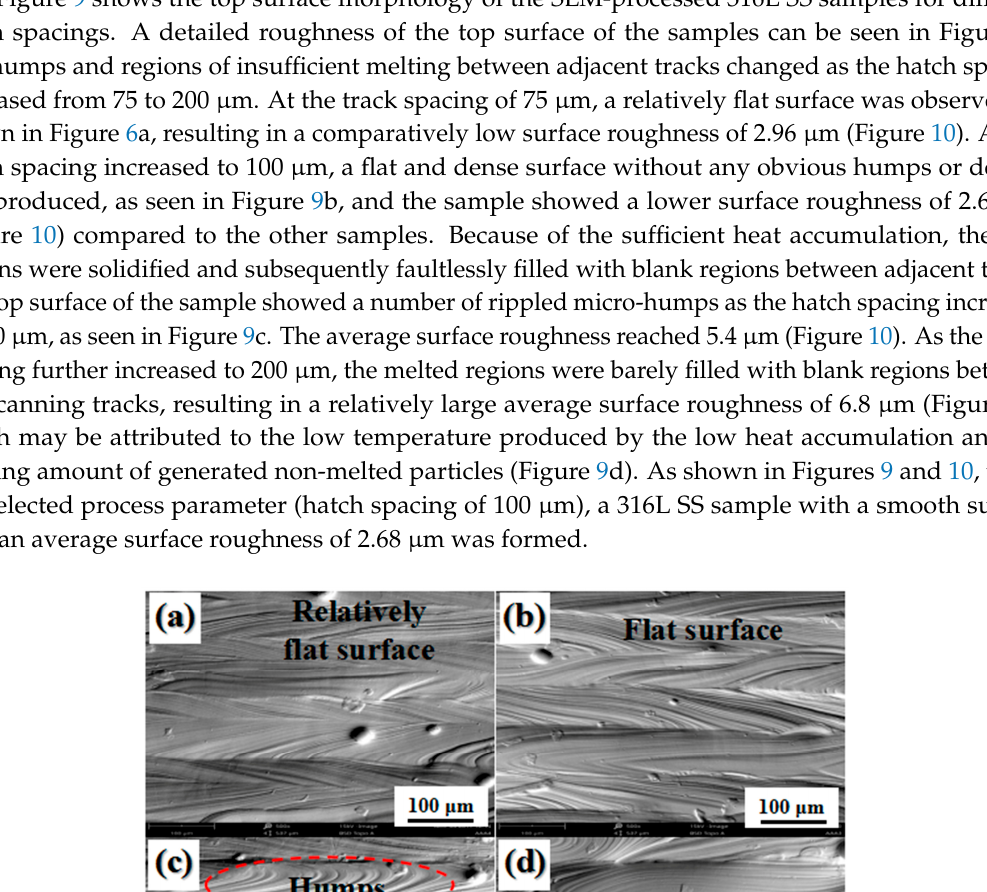
Figure 8. Simulated (left) and experimental (right) overlap rate between adjacent tracks for various hatch spacings: ( a ) H = 75 µ m, ( b ) H = 100 µ m, ( c ) H = 150 µ m, and ( d ) H = 200 µ m.